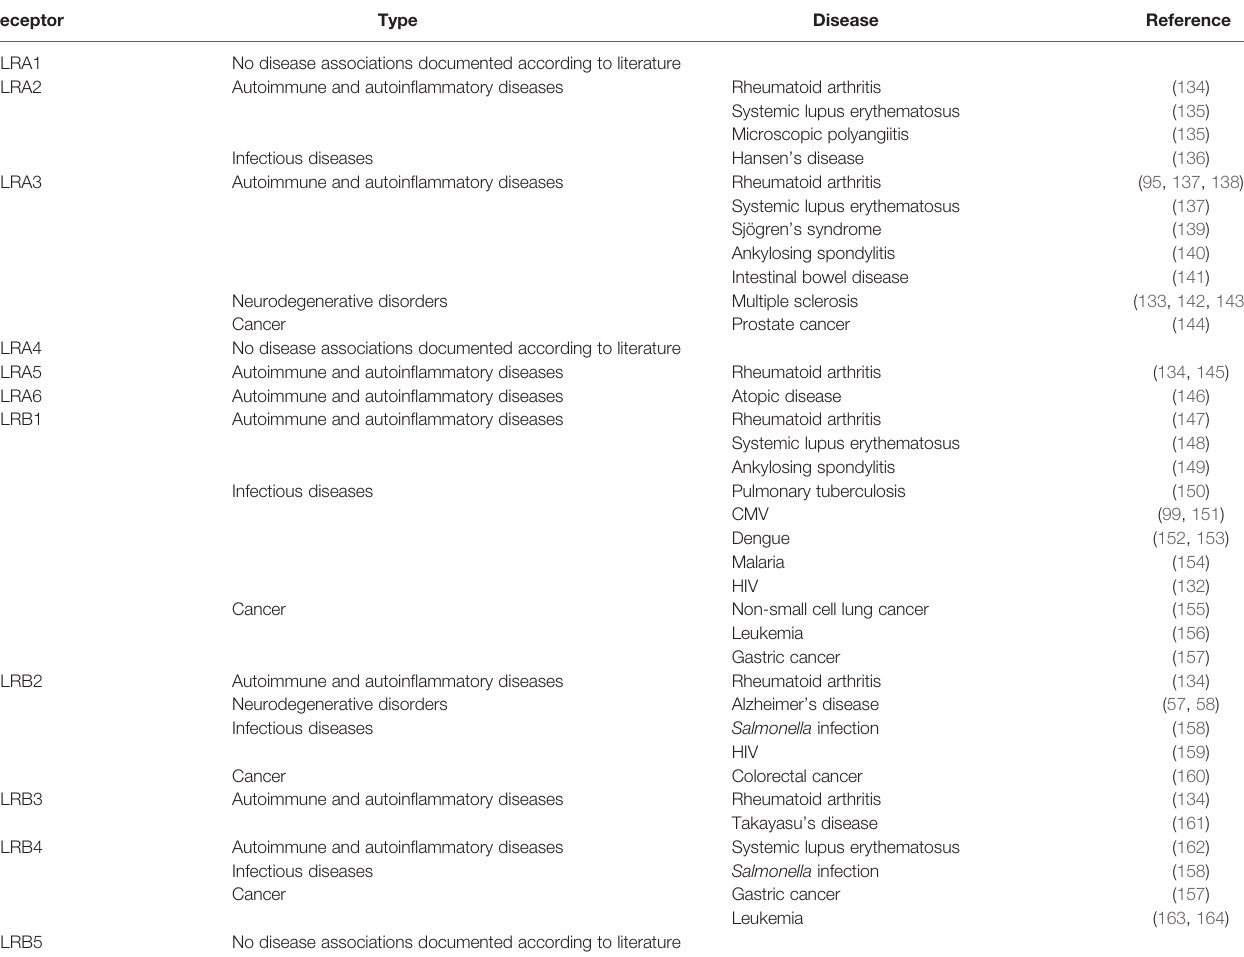
TABLE 2 | Overview of human LILR receptors and their associations with disease.